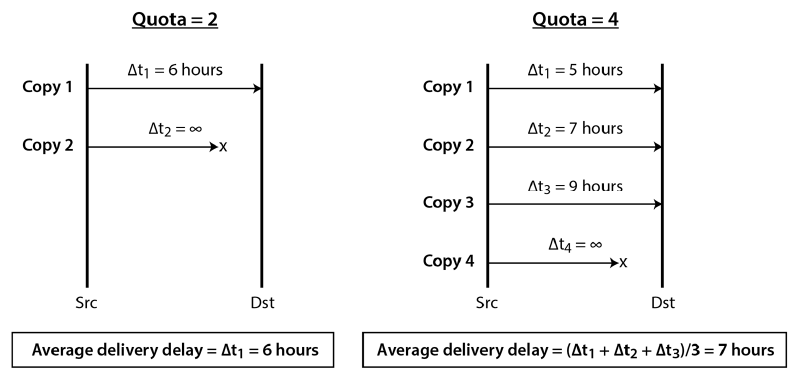
Figure 20. Multiple deliveries of the same message and its impact on average delivery delay.